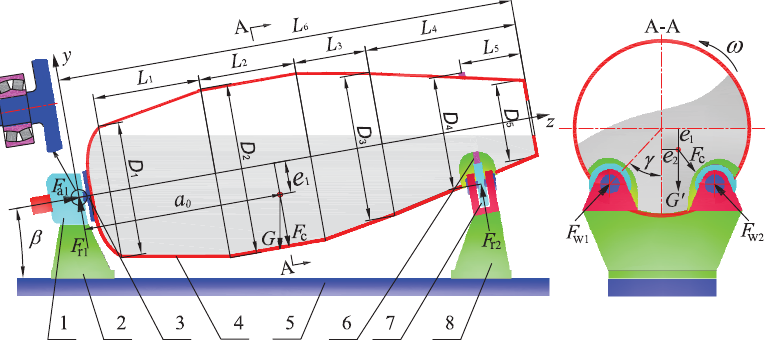
Figure 1. Structure and mechanics analysis of the concrete mixer system. 1: gear reducer, 2: front bracket, 3: flange, 4: mixing drum, 5: subframe, 6: raceway, 7: rolling wheel 8: rear